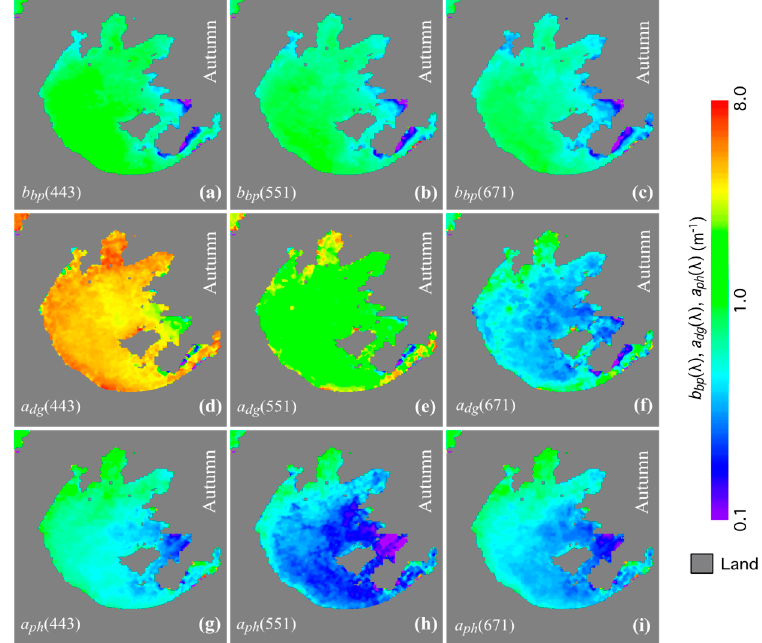
Figure 8. VIIR-derived IOP in Lake Taihu during the autumn season between 2012 and 2018 for ( a – c ) b bp ( λ ), ( d – f ) a dg ( λ ), and ( g – i ) a ph ( λ ) at the VIIRS bands of 443 nm (left column), 551 nm (middle column), and 671 nm (right column).